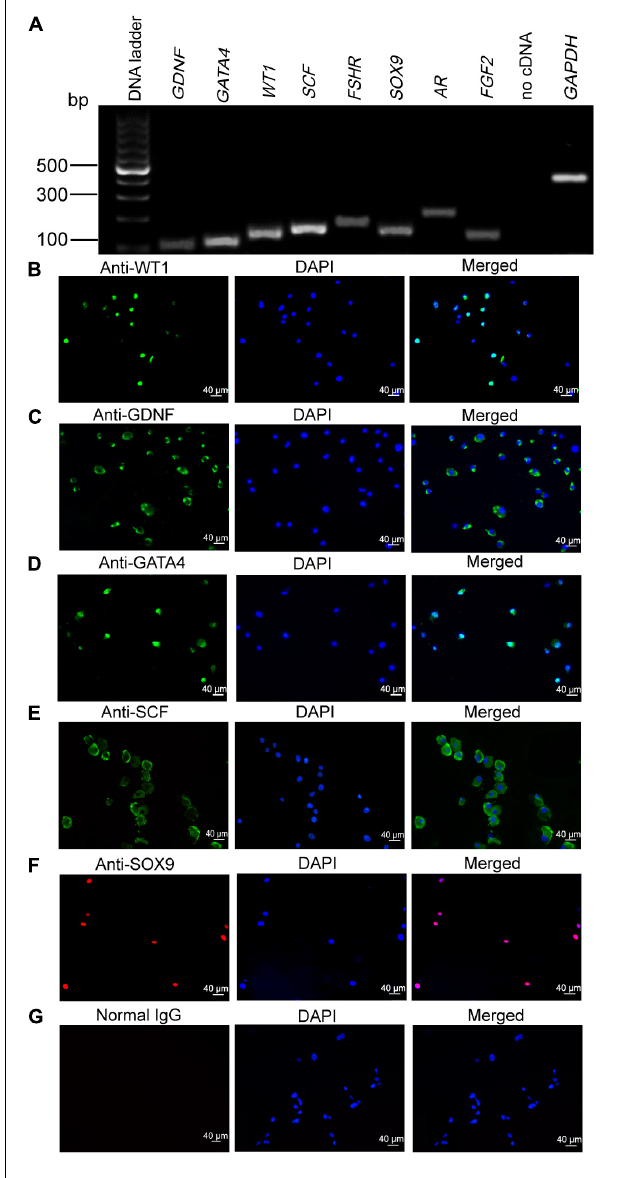
FIGURE 1 | Phenotype of human Sertoli cells. (A) The transcripts of glial cell-derived neurotrophic factor ( GDNF ), GATA binding protein 4 ( GATA4 ), Wilms’ tumor gene 1 ( WT1 ), stem cell factor ( SCF ), follicle-stimulating hormone receptor ( FSHR ), SRY-related high-mobility group-box gene 9 ( SOX9 ), androgen receptor ( AR ), and fibroblast growth factor 2 ( FGF2 ) were detected by RT-PCR in human Sertoli cells. Housekeeping gene glyceraldehyde 3-phosphate dehydrogenase ( GAPDH ) was used to be the RNA loading control. (B–G) Immunocytochemistry revealed the positive cells of WT1 (B) , GDNF (C) , GATA4 (D) , SCF (E) , SOX9 (F) , and isotype IgGs (G) in human Sertoli cells. Scale bar in panels (B–G) = 40 µ m.